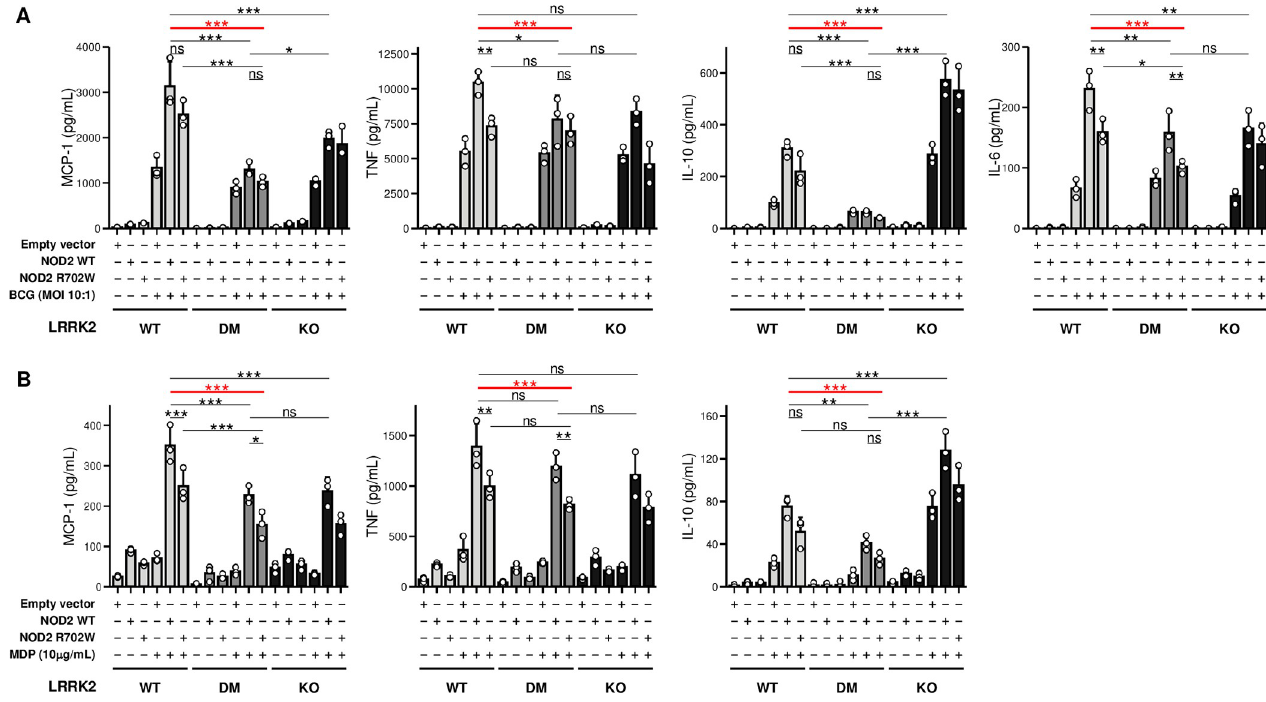
Fig 5. Effects of LRRK2 and NOD2 on cytokine secretion in response to BCG infection or stimulation with N-glycolyl MDP. Cell culture supernatant concentrations for MCP-1, TNF, IL-10 and IL-6 in cells expressing LRRK2 WT, LRRK2 DM (N551K+R1398H) or devoid of LRRK2 (KO) and transfected with NOD2 wild-type (WT), NOD2 R702W or empty vector. Secreted cytokines were measured following ( A ) infection with live bacillus Calmette–Gue´rin (BCG) or ( B ) stimulation with N-glycolyl MDP. The concentrations of IL-6 triggered by N-glycolyl MDP stimulation were below the detection limit and are not shown. A-B Results are presented as mean ± SD of a representative experiment done in triplicate of three independent experiments. Significance of difference between LRRK2 WT+NOD2 WT and the genotype carried by the early onset leprosy twins (LRRK2 DM+NOD2 R702W) is indicated in red. *** P < 0.001; ** 0.001 � P < 0.01; * 0.01 � P < 0.05; ns: non-significant.